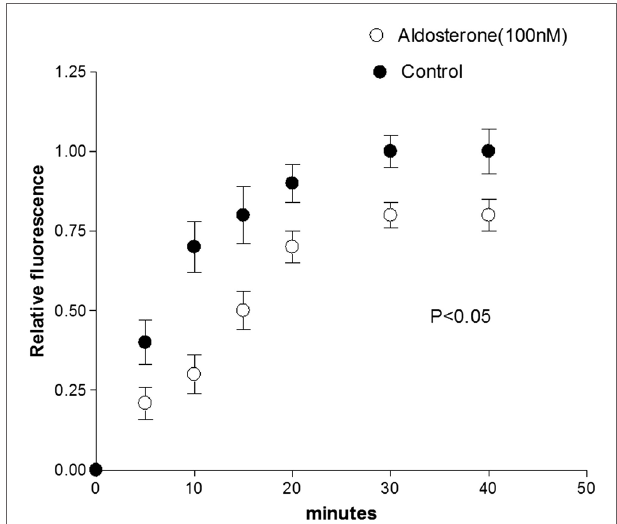
FigUre 2 | inhibition of cell-to-cell diffusion of fluorescent glucose in cell pairs exposed to aldosterone (100 nM) for 24 h . Each point is the average from 25 cell pairs (four animals) isolated from the left ventricle. Vertical line at each point SEM ( P < 0.05).